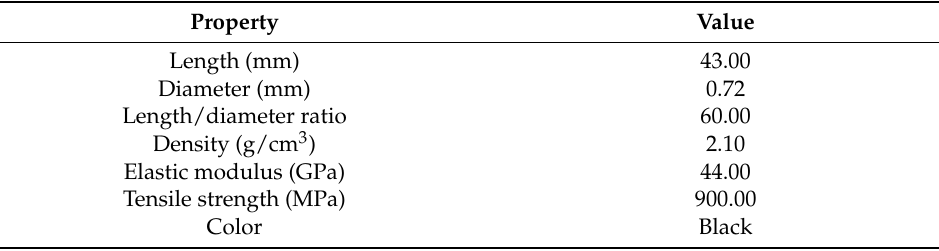
Table 3. Physical and geometric characteristics of BMF data from [32].